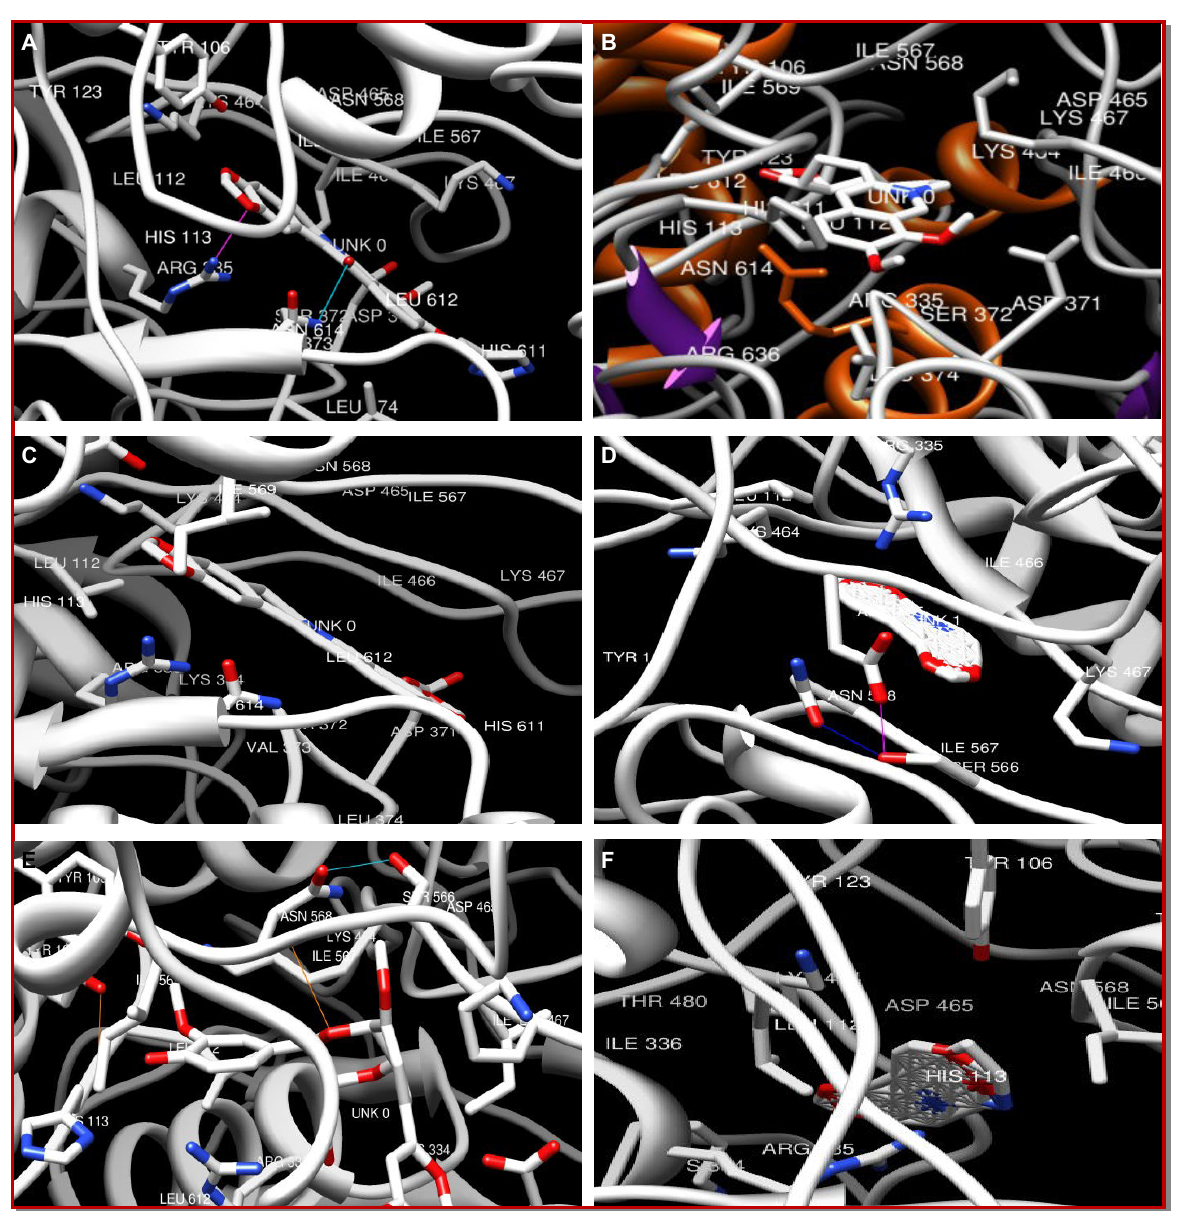
Figure 2: The interactions of the berberine betaine (A), berberine (B), coptisine (C), cyanodihydroberine (D), dihydroberbeine (E), methoxyhydroberberine (F), oxycanthine (G), palmitine (H), and 9,10-dimethoxy-5,8-dihydro-6H-[1,3]dioxolo[4,5-g] isoquino[3,2- a] isoquinoline (I) against the proteins. The colors below were represented as the interacting hydrogen bonds between the protein and the